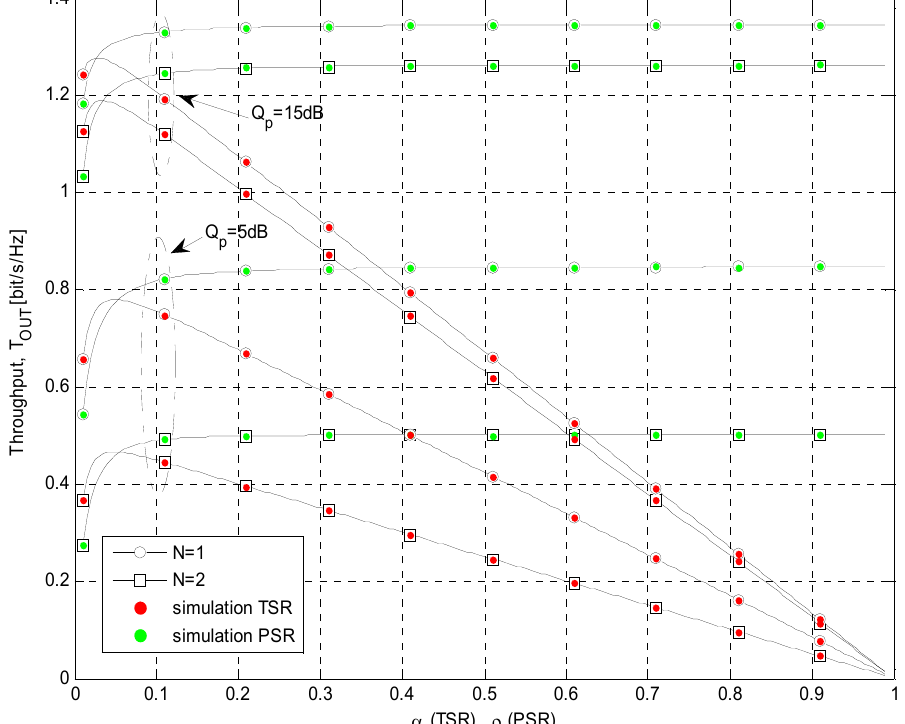
Figure 6. Throughput vs. energy harvesting ratio.